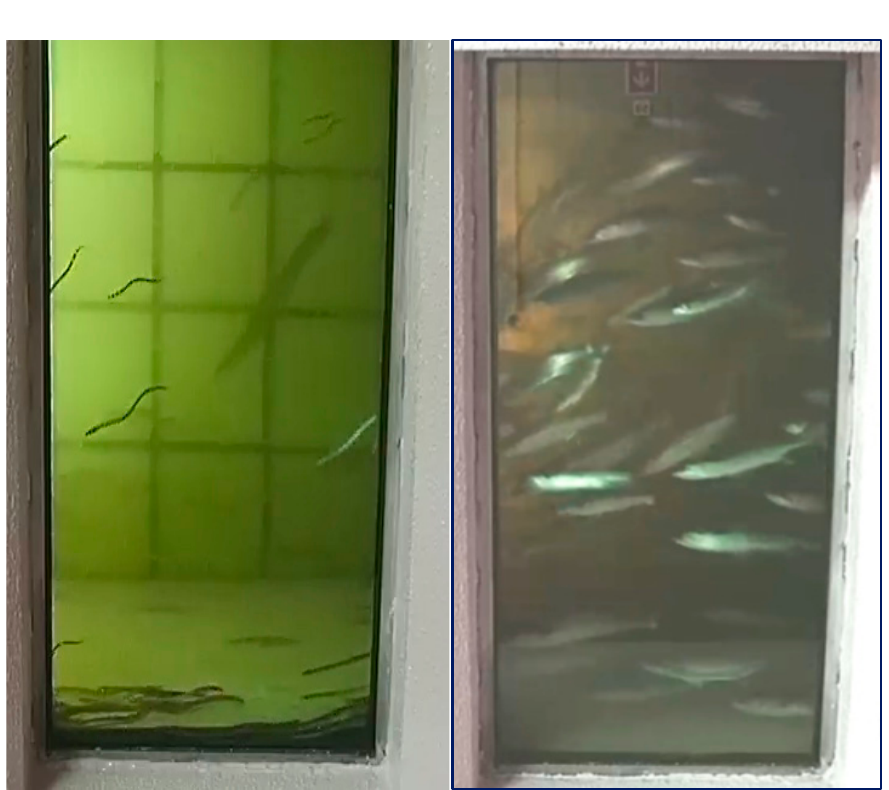
Figure 2. Viewing window in the upper lock chamber with several European eels ( left ) and mullets ( right ) passing